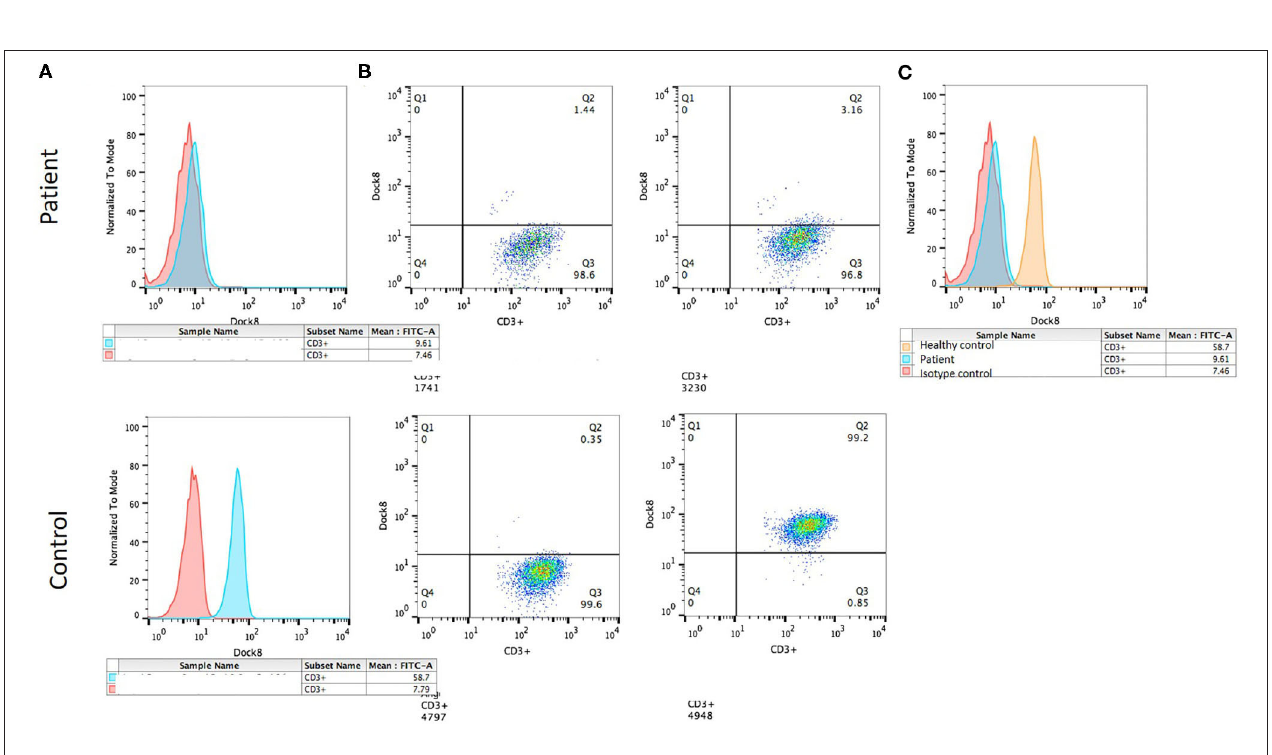
Frontiers in Pediatrics |